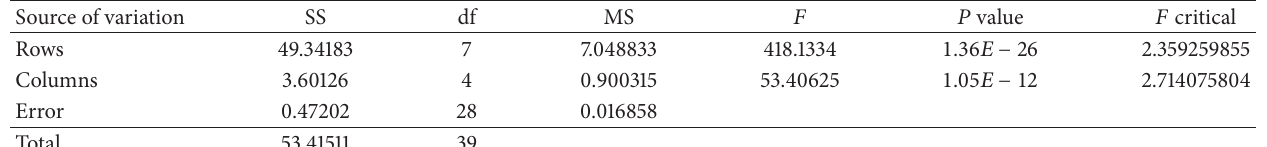
Table 8: Flow test results (ANOVA: two-factor without replication).